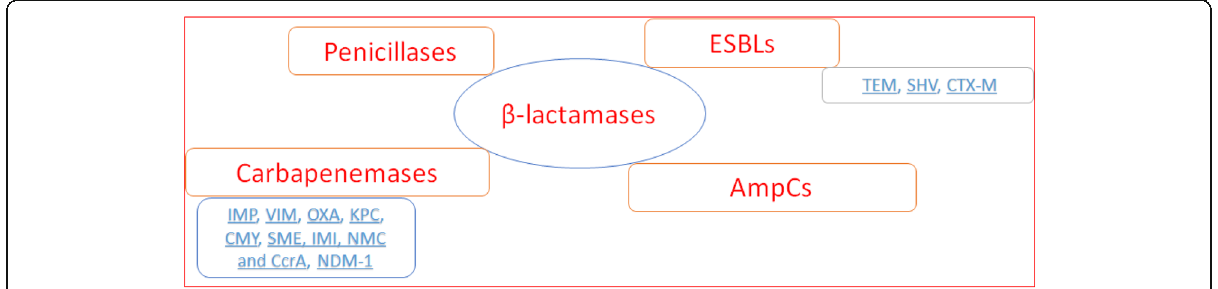
Fig. 1 β -Lactamases produced by Gram-negative bacteria. Key: IMP-type carbapenemases (metallo- β -lactamases) (class B), VIM (verona integron- encoded metallo- β -lactamase) (class B), OXA (oxacillinase) group of β -lactamases (class D), KPC ( K. pneumoniae carbapenemase) (class A), CMY (class C), SME, IMI, NMC (metallo- β -lactamases) and CcrA, and NDM-1 (New Delhi metallo- β -lactamase) (class